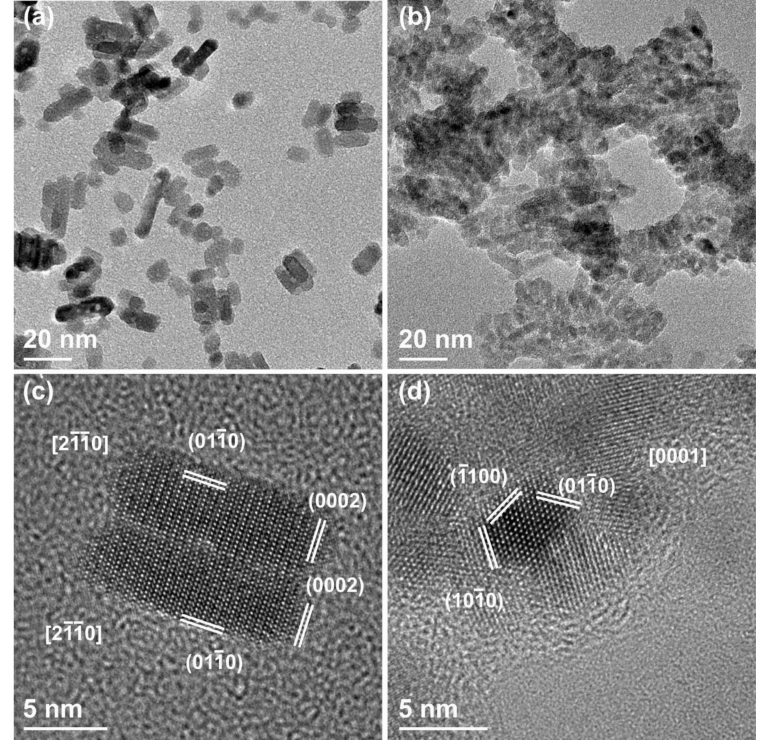
Figure 3. ( a , b ) Conventional transmission electron microscopy (CTEM) and ( c , d ) high-resolution transmission electron microscopy (HRTEM) images of ( a , c ) pristine ZnO-st NCs and ( b , d ) functionalized ZnO-st-NH 2 , both obtained via solvothermal